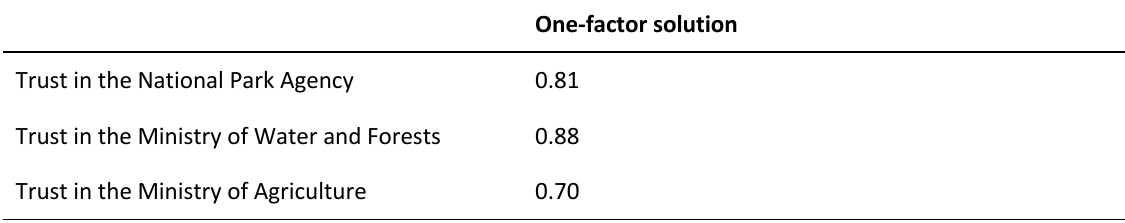
Table A1.1b: Factor loading of the institutional trust indices